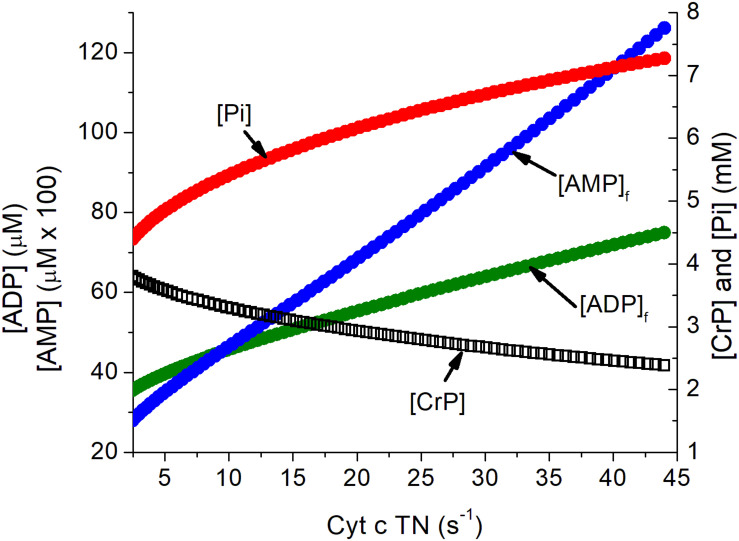
Simulation of the relationship of the concentration of energy metabolites to cytochrome c turnover (oxygen consumption). Simulation was carried out as described previously (Wilson, 2017). The concentrations of ATP, total creatine (CrP + Cr), and cytochrome c ([cyt c]), were assumed to be 4.5 mM, 8 mM, and 8 μM, consistent with experimental measurements in brain tissue. Values for [AMP]f and [ADP]f assumed equilibrium for adenylate kinase (Keq = 1.0) and creatine kinase (Keq = 140). The cytochrome c turnover number can be converted to oxygen consumption by multiplying by [cyt c] and dividing by 4, i.e., a turnover number of 10 s–1 corresponds to oxygen consumption of 20 μM s–1, 1.2 mM/min, or 2.7 ml/100 g s–1. The assumed [cyt c] of 8 μM is conservative and could be as high as 12 μM.